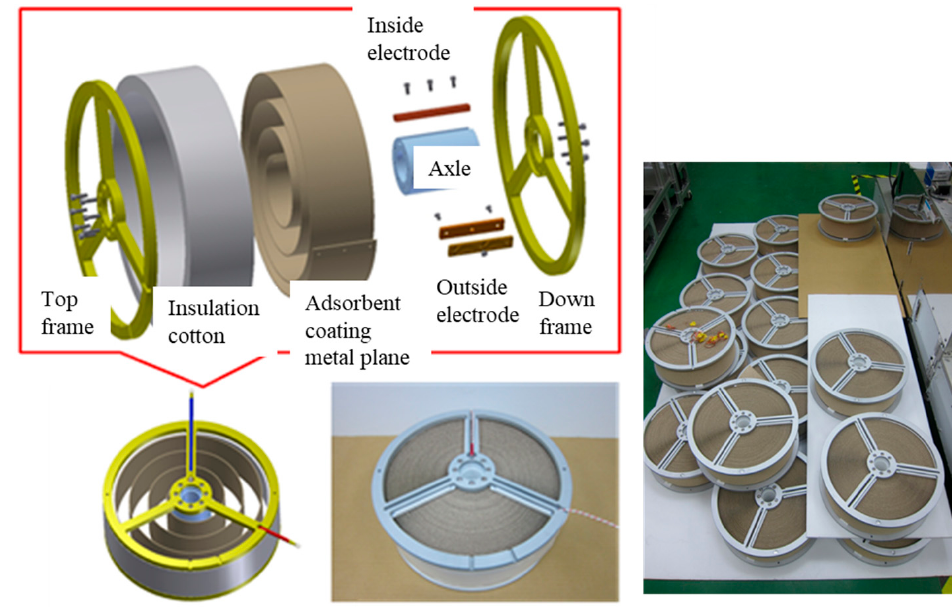
Figure 13. Structural schematic of the proposed